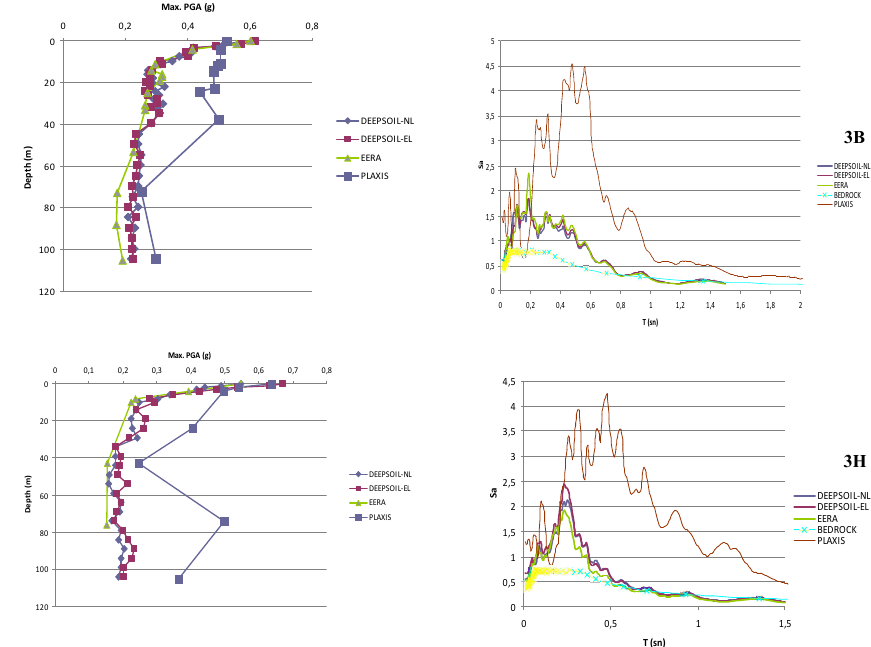
Figure 17. 3-3 0 section; maximum acceleration depth and spectral acceleration period graph for the selected